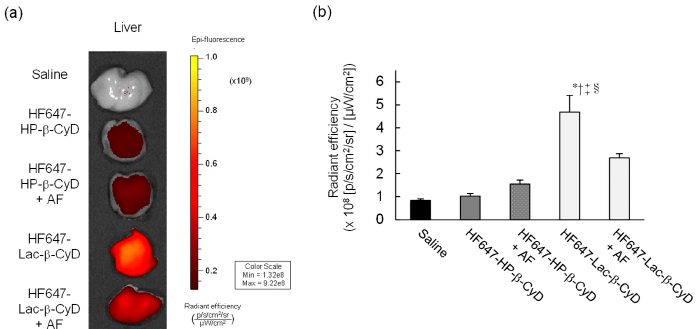
Figure 1. In vivo fluorescence imaging of HF647-Lac- β -CyD. ( a ) Liver accumulation of HF647-Lac- β -CyD and HF647-HP- β -CyD. The liver was harvested 60 min after subcutaneous administration of HF647-Lac- β -CyD (20 mg / kg) or HF647-HP- β -CyD (10 mg / kg) to WT mice, and fluorescence intensity of the liver was detected by IVIS. These figures show the representative images of 3 mice. ( b ) E ff ect of ASGPR on liver accumulation of HF647-Lac- β -CyD. AF (500 mg / kg) was intraperitoneally administered to WT mice 1 min before and 5 min after subcutaneous administration of HF647-Lac- β -CyD. After 60 min, the liver was harvested, and the fluorescence intensity was detected by